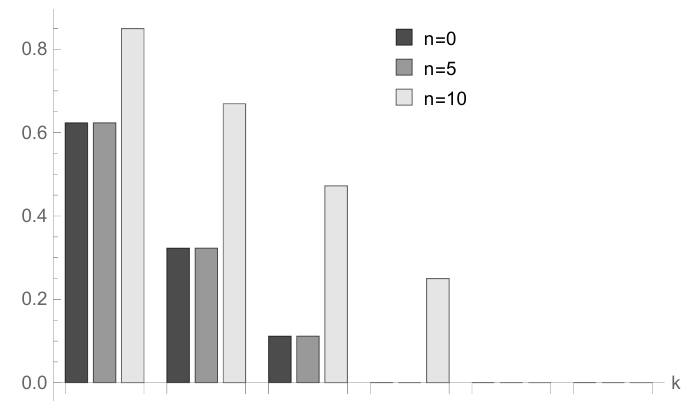
Figure 7. Conditional probabilities (cid:98) ∆ n ( k ) for geometric processing distribution, (cid:36) = 0.75 and n = 0, 5 and 10.